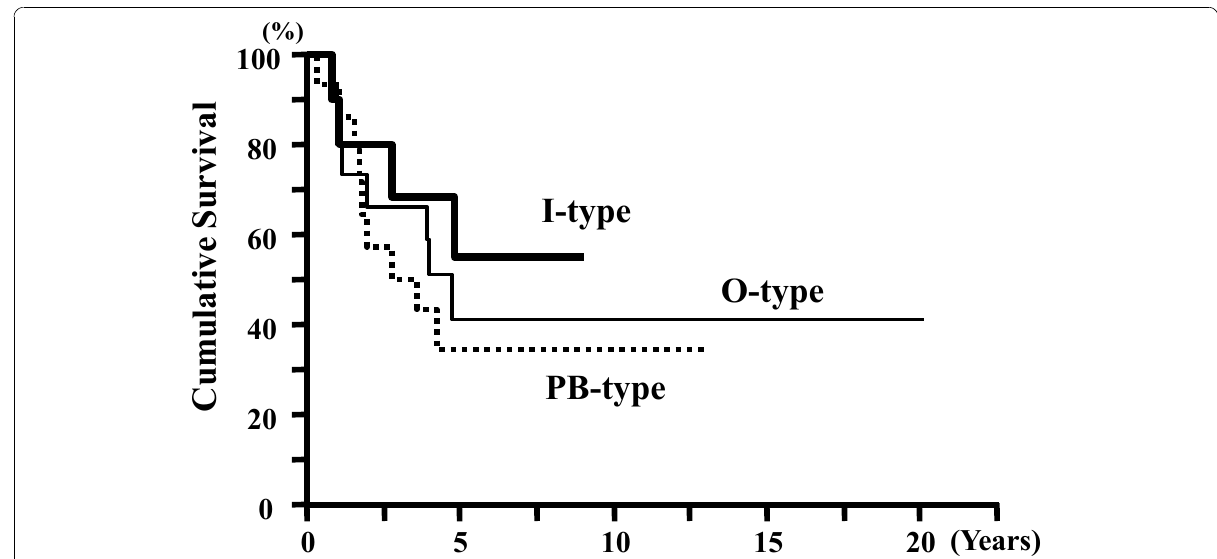
Figure 5 Cumulative survival of patients based on immunohistochemical classification (I-type, PB-type, and O-type) . There were no differences among the 3 immunohistochemical subtypes in terms of cumulative survival of patients with AC (p =